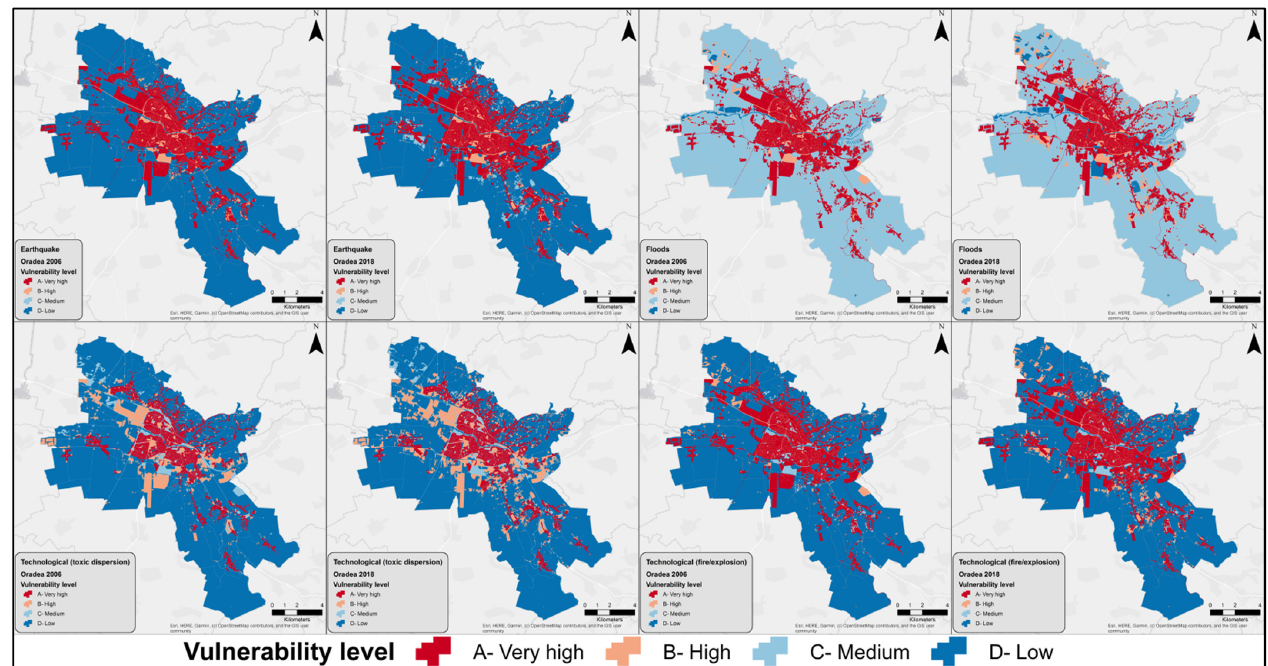
Figure 7. Visualization of temporal and spatial variation in vulnerability level for Oradea FUA.